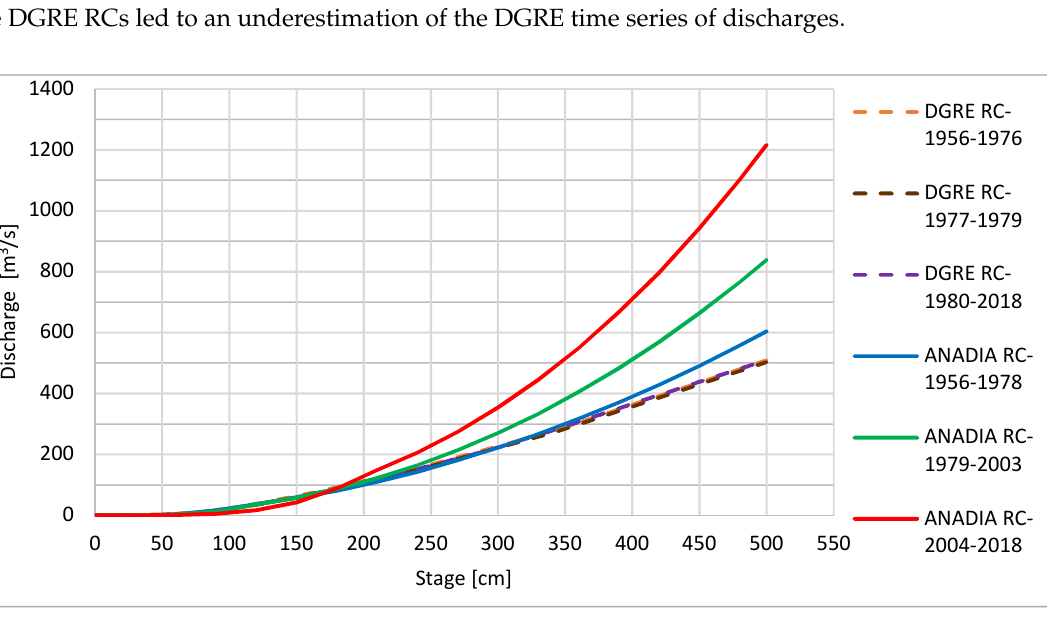
Figure 2. Overlapping of the DGRE RCs (dotted lines) and ANADIA RCs (solid lines) for the different periods.